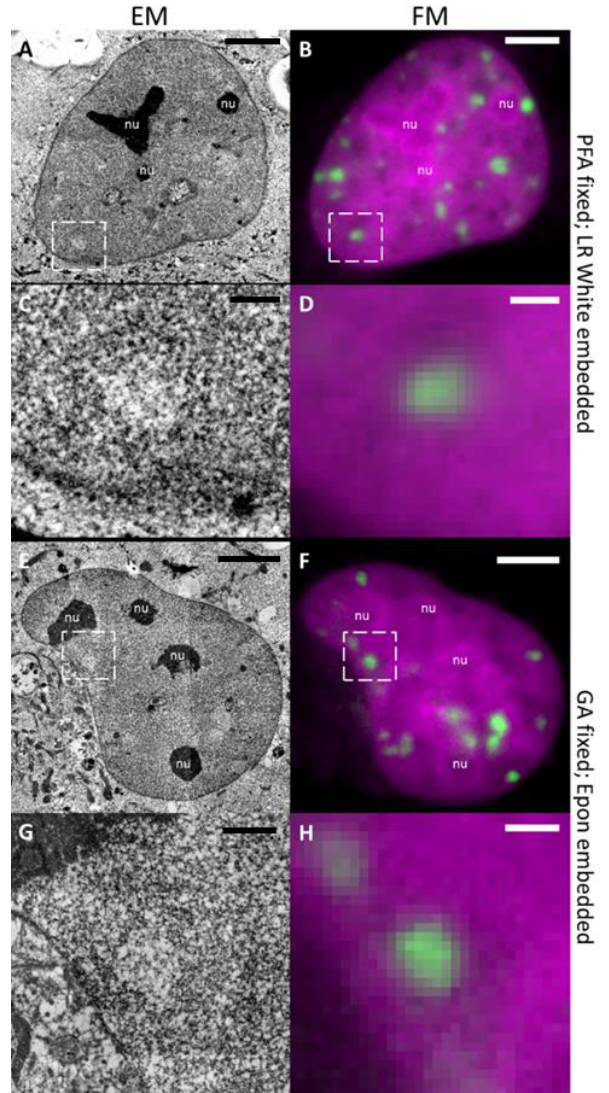
Figure 2. LDA phenotype is tolerant to different fixation and embedding conditions. Samples were PFA fixed and embedded in LR White ( A – D ) or GA fixed and embedded in Epon ( E – H ). Both samples clearly show LDAs in TEM images (left column). The whole nucleus imaged with TEM ( A & E ) or with FM ( B & F ) is shown. In C & G and D & H a single LDA (dashed white box of A & E and B & F ) is magnified. All LDAs in the TEM images correlate with 53BP1-GFP IRIFs (green) of the FM images. Scale bar: A, B,E & F 5 µm, C , D,G & H 1 µm.